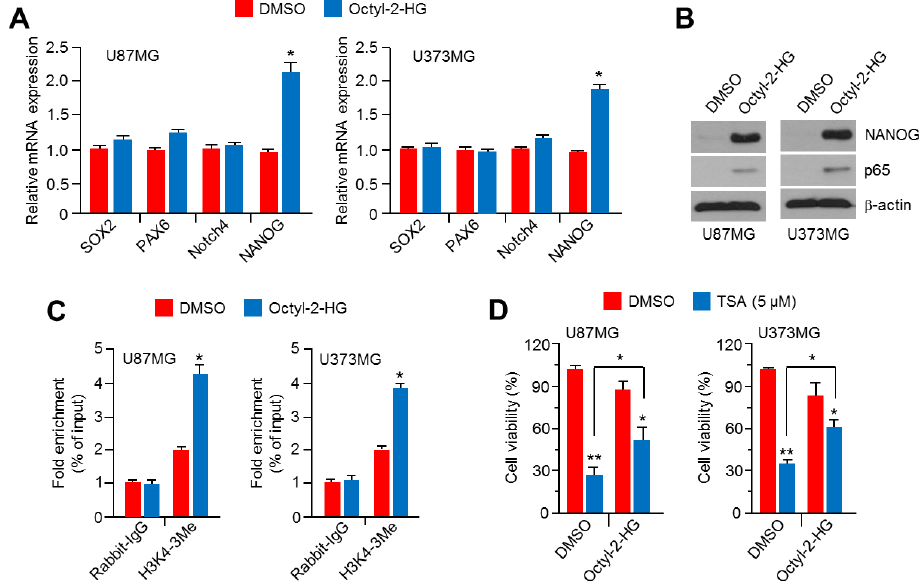
Figure 6. Octyl-2HG increases NANOG expression and causes TSA resistance in U87MG and U373MG glioblastoma cells. ( A ) U87MG and U373MG cells were incubated in the absence or presence of octyl-2HG (1 mM) for 24 h. Gene expression was measured by using qRT-PCR. The values represent the mean ± SD of three independent experiments performed in duplicate; * p < 0.05. ( B ) Protein levels were measured by using western blotting. ( C ) U87MG and U373MG cells were incubated with or without octyl-2HG (1 mM) for 24 h. Chromatin immunoprecipitation was performed by using antibody against for H3K4-3Me. Purified DNA samples were used to analyze the promoter region in NANOG gene. The values represent the mean ± SD of three independent experiments performed in duplicate; * p < 0.05. ( D ) U87MG and U373MG cells were incubated with or without TSA (5 µ M) or octyl-2HG (1 mM) for 48 h. Cell viability was analyzed by using crystal violet staining. The values represent the mean ± SD of three independent experiments performed in duplicate; * p < 0.05 and ** p < 0.01.